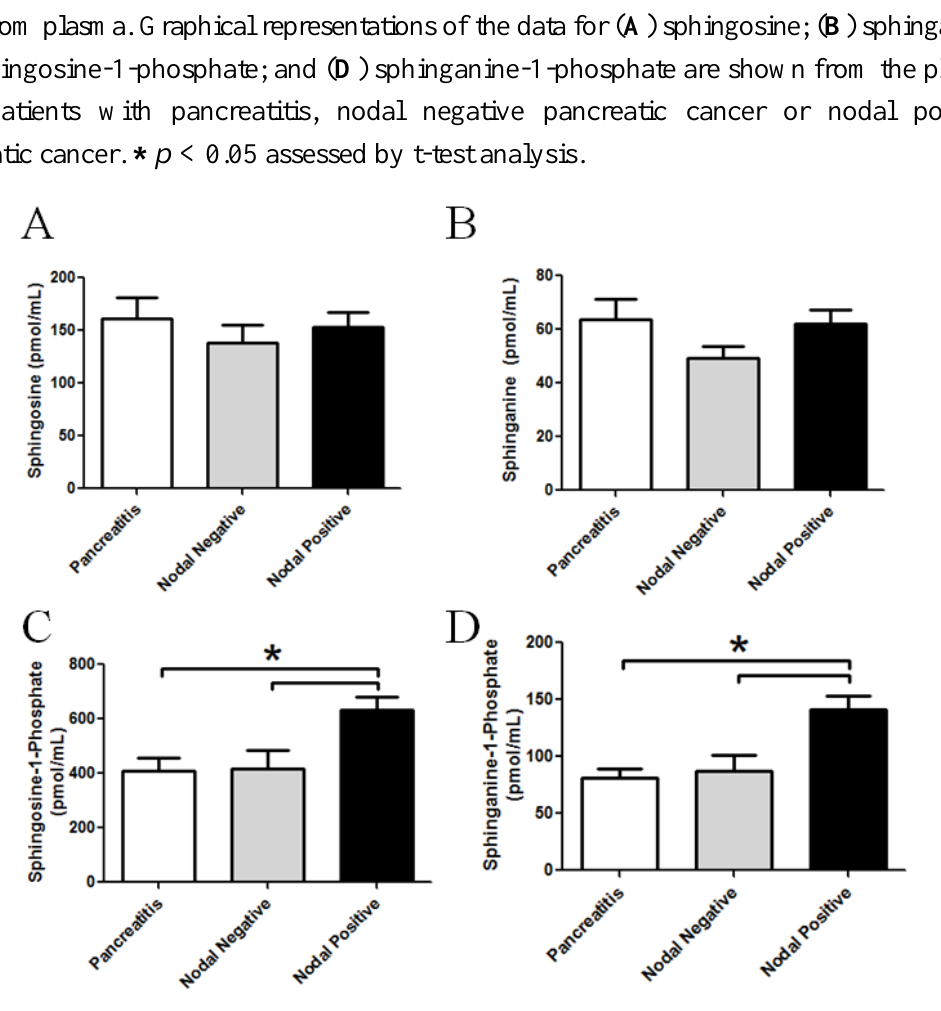
bases from plasma. Graphical representations of the data for ( A ) sphingosine; ( B )